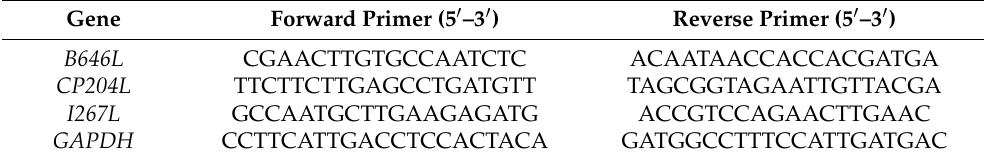
Table 1. Primers were used to assay gene expression by real-time quantitative PCR. Gene Forward Primer (5 (cid:48) –3 (cid:48)